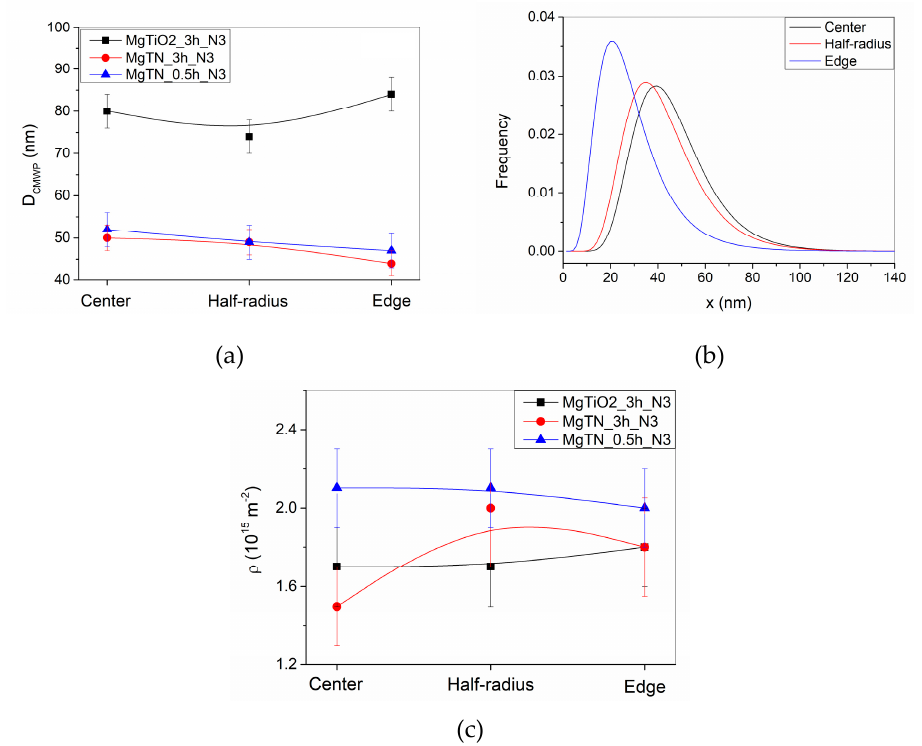
Figure 7. Microstructural parameters obtained by the CMWP analysis of the Mg-based disks (N = 3) along their radius. Average crystallite sizes ( a ), lognormal size-distribution functions of MgTN_3h_N3 ( b ) and average dislocation densities ( c ).